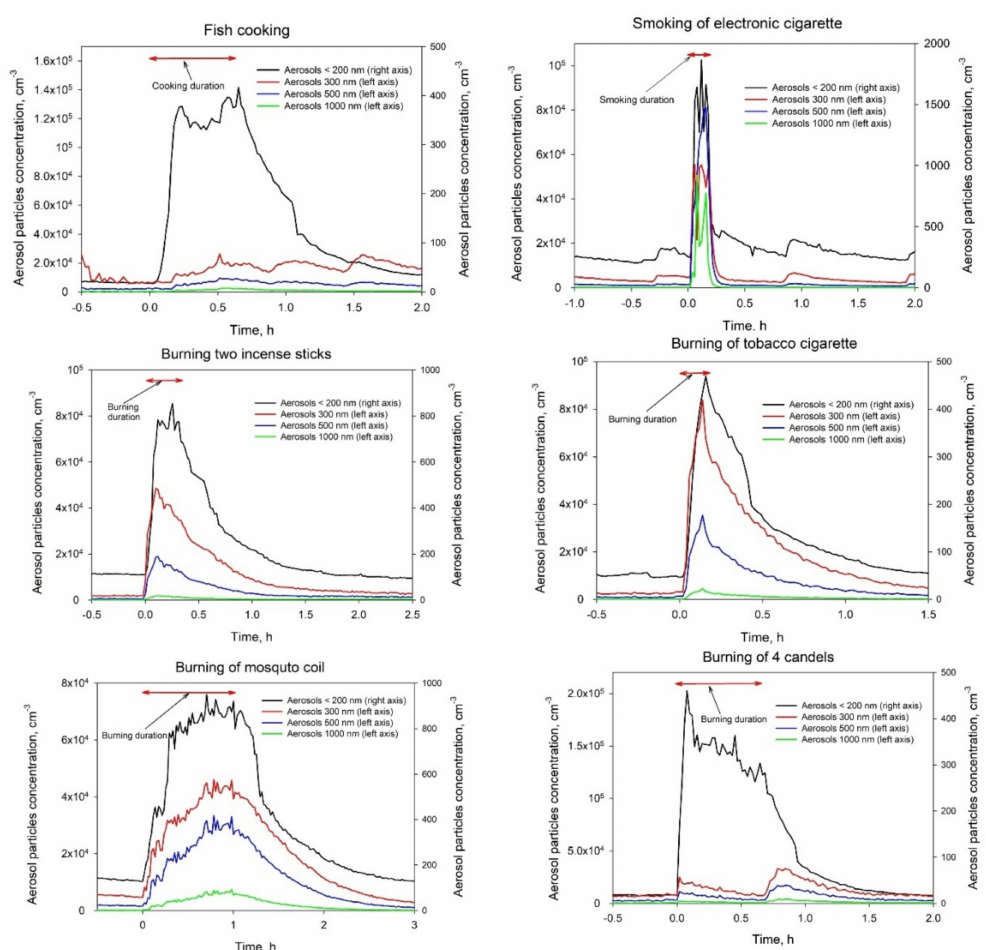
Figure 2. UFP (<200 nm) and fine particle concentration generated by six different aerosol sources (burning duration means when the aerosol source was on), as measured by the DAS. Left Y-axis for UFP (<200 nm) and right Y-axis for other